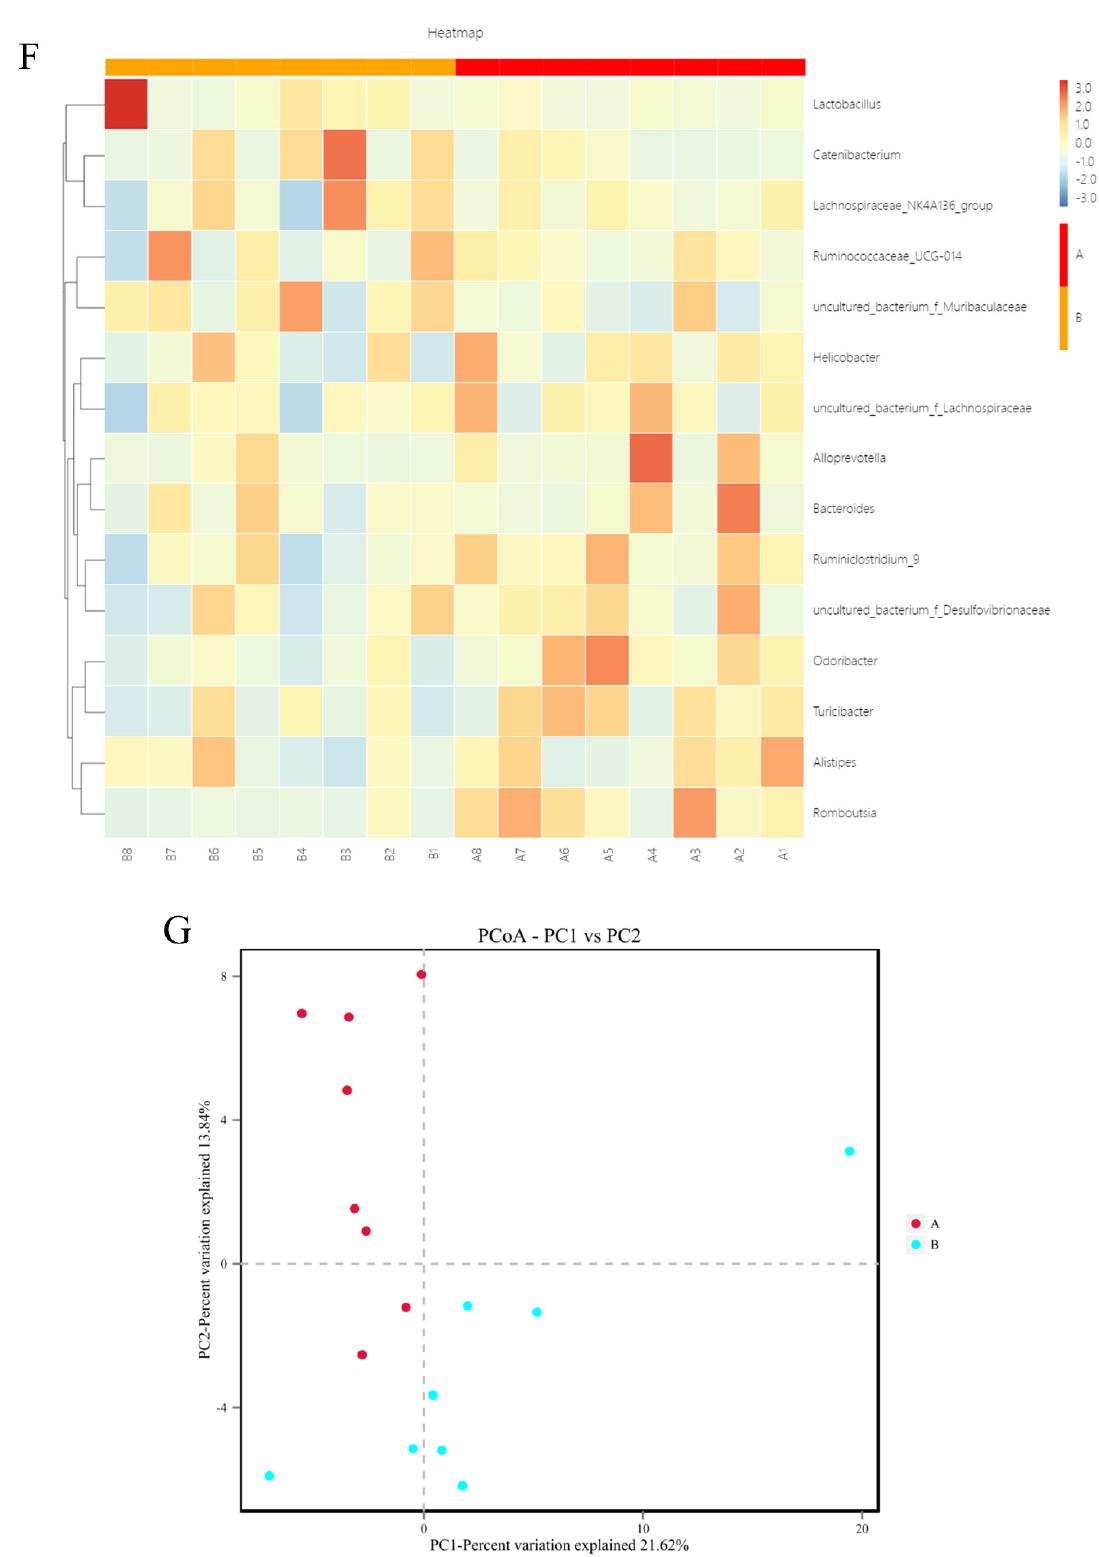
Figure 4. Effects of adding SPD to drinking water on intestinal microbiota in mice. ( A ) OTU quantity statistics. ( B , C ) Microbial composition of the mouse intestinal tract at the phylum level. ( D , E ) Microbial composition of the mouse intestinal tract at the genus level. ( F ) Heatmap of species clustering at the genus level. ( G ) PCoA of the control group and the 3.0 mmol/L spermidine treatment